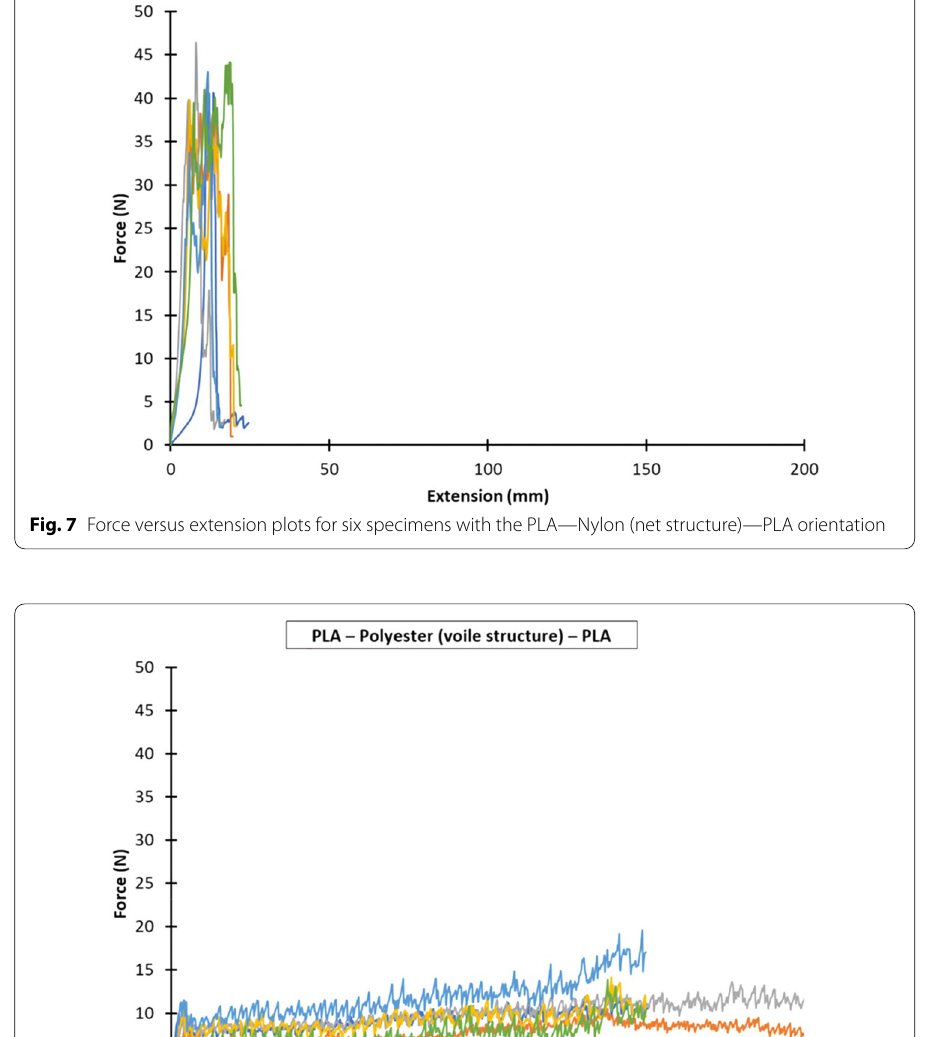
failure modes for the PLA—Nylon (net structure)—PLA, PLA—Polyester (voile struc- ture)—PLA and PLA—Nylon (voile structure)—PLA orientations, respectively. The fail- ure mode classification was based on BS EN ISO 10365 (1995). For the two orientations with Nylon net structure (Fig. 4) and voile structure (Fig. 6), both were the failure of an adherend, caused by the fracture of printed PLA layer (cohesive substrate failure). On the other hand, the orientation with Polyester voile structure showed an adhesion failure mode, delamination of printed PLA layer (substrate) from the textile, shown in Fig. 5c.